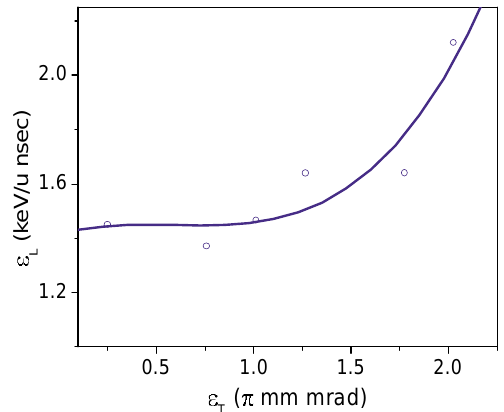
FIG. 7. (Color) Longitudinal emittance of 99.9% of the total accelerated particles ´ L in the RFQ as a function of input trans- verse normalized emittance ´ nT .